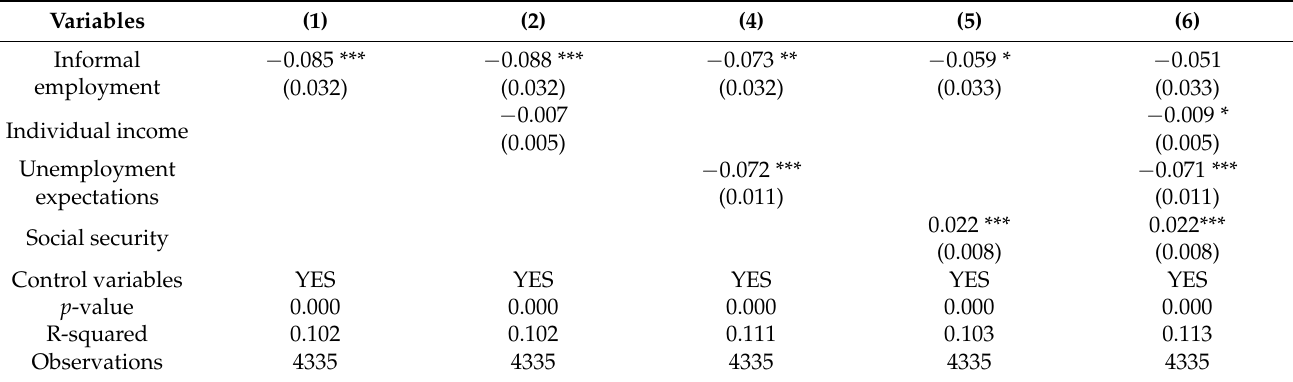
Table 5. Expanded model of informal employment and residents’